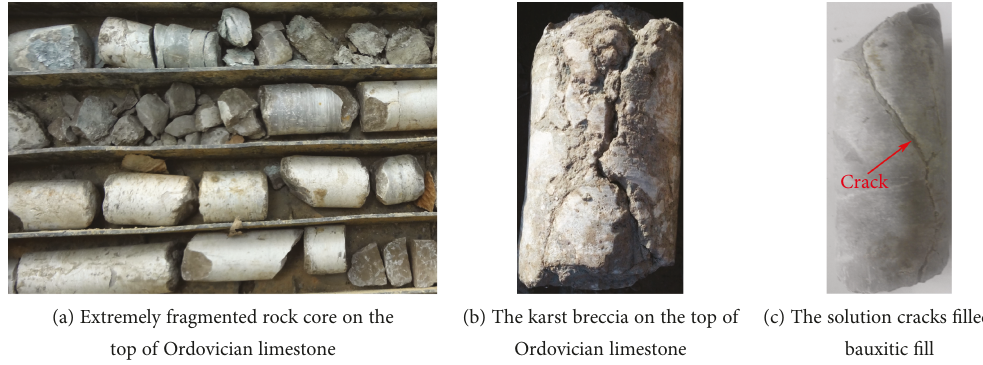
Figure 4: Drilling core on the top of Ordovician limestone.